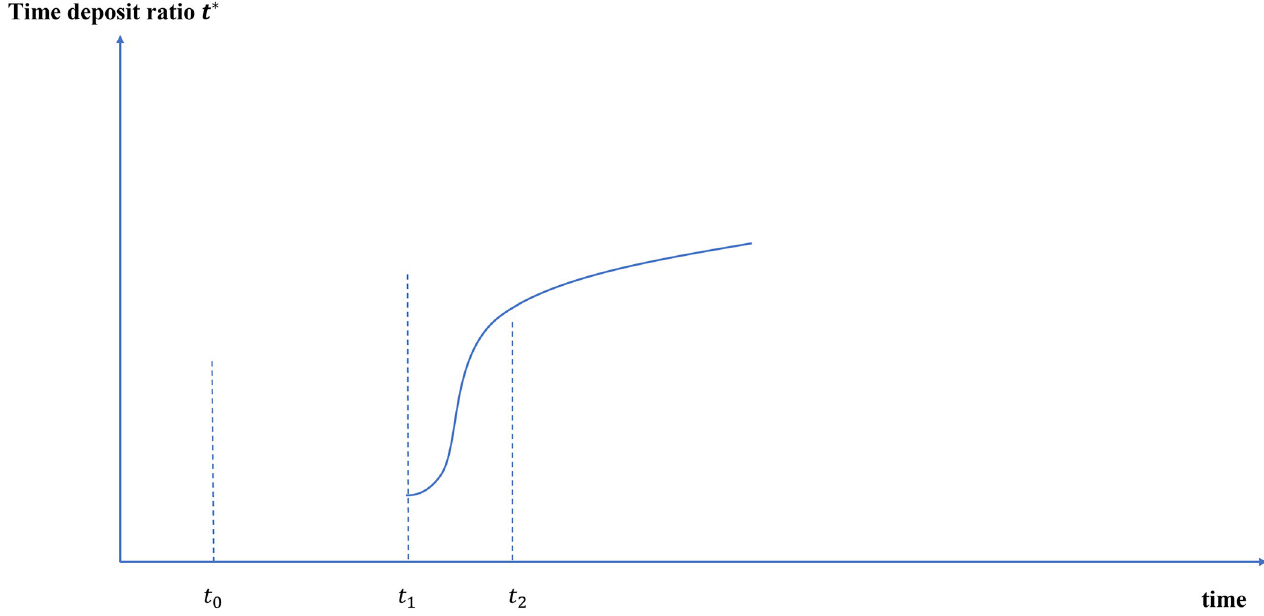
PLOS ONE | https://doi.org/10.1371/journal.pone.0268471 July 8,